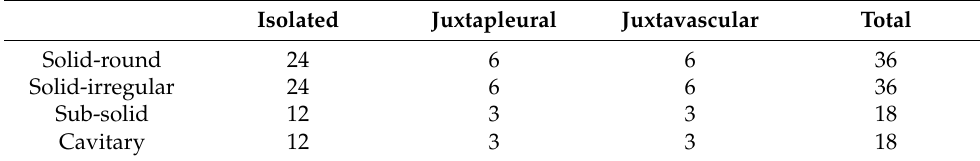
Table 3. The number of cases in each category and subcategory of the altered phantom dataset. Isolated Juxtapleural Juxtavascular Total